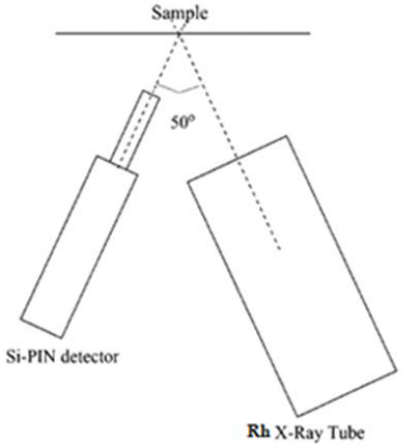
Figure 3. Schematic drawing of apparatus for X-ray fluorescence spectroscopy.